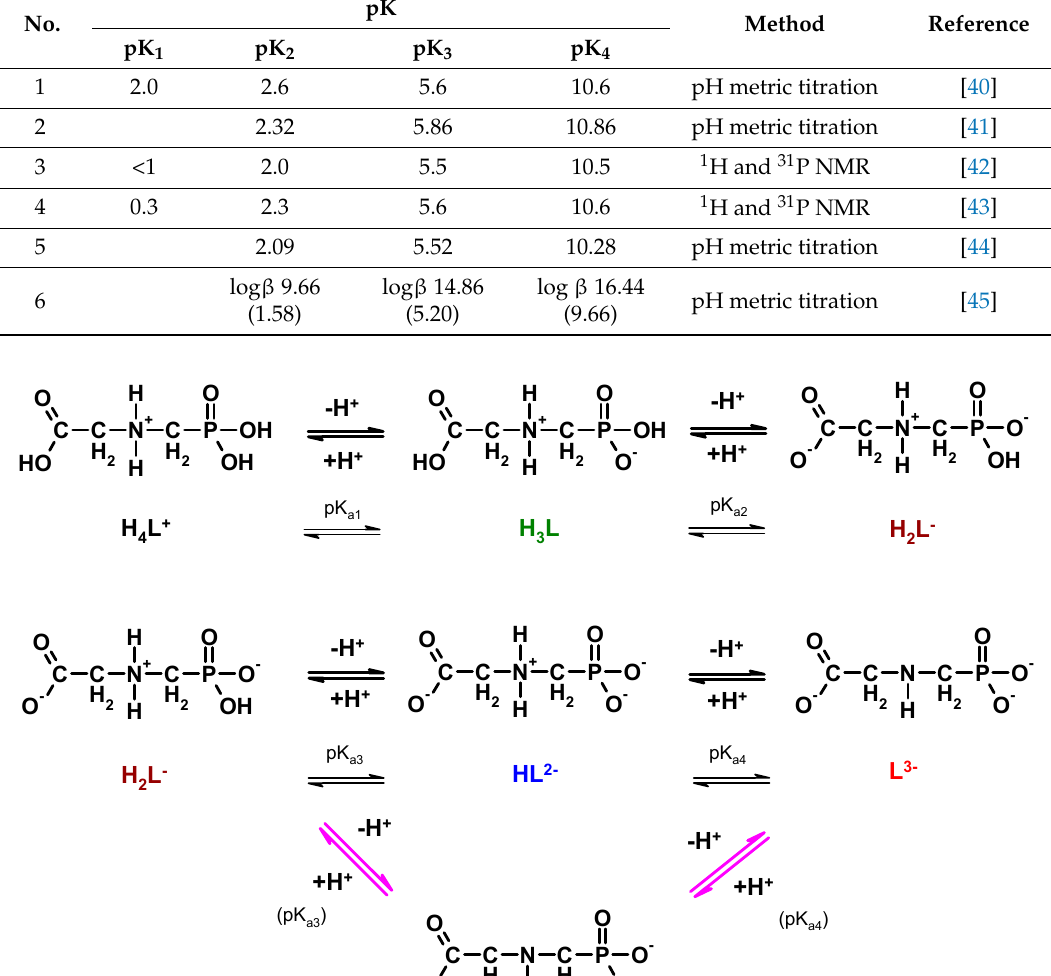
Table 5. Representative works on pKa determination of PMG.